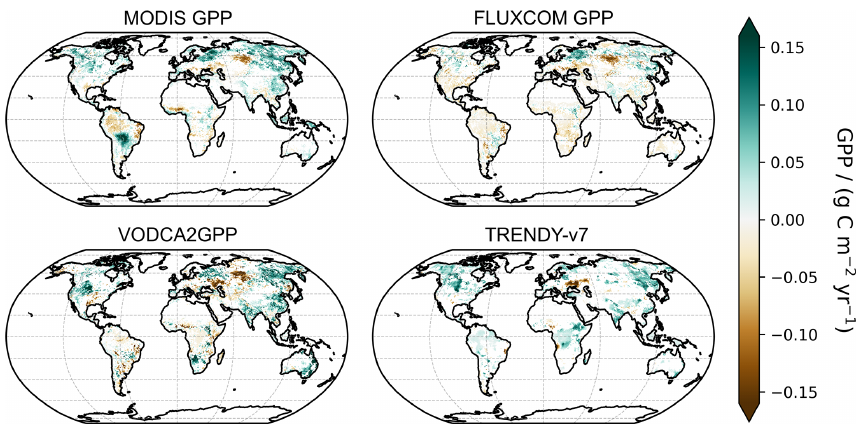
Figure 8. Global map of trends in yearly median GPP for the period 2003–2015 for all analysed datasets. White indicates non-significant trends.